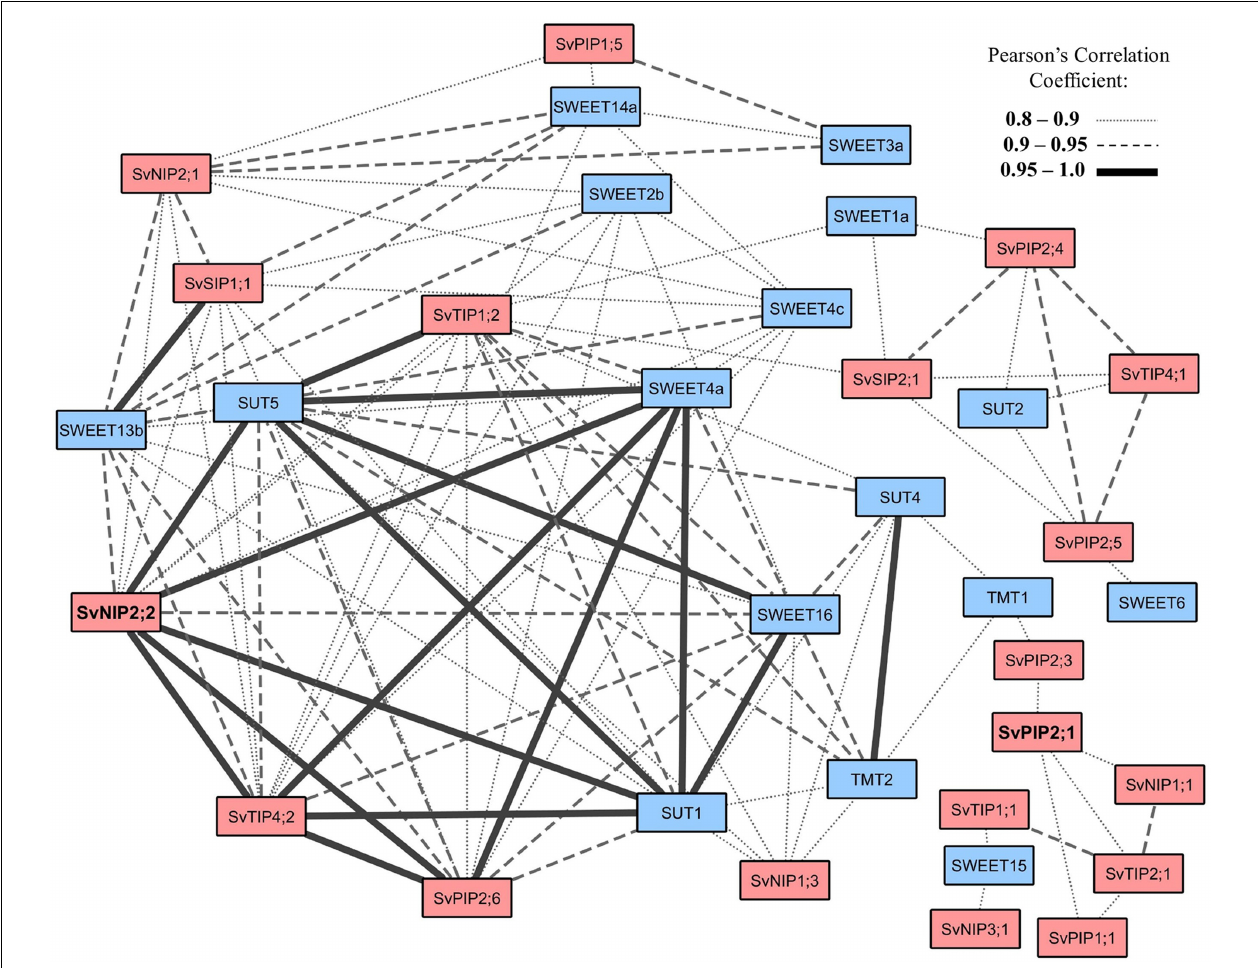
FIGURE 4 | Co-expression network of putative S. viridis aquaporin and sugar transporter genes identified in an elongating internode. The co-expressed gene network was generated from the stem specific aquaporins ( Figure 2 ) and sugar transporters identified in the S. viridis elongating internode transcriptome reported by Martin et al. (2016). Raw FPKM values were Log 2 transformed and Pearson’s correlation coefficients (0.8–1.0) were calculated in the MetScape app in Cytoscape v3.4.0. Sugar transporters in the S. viridis elongating internode were identified by homology to rice sugar transporter genes (Supplementary Figures S2–S4). Sugar transport related genes are color filled with blue and aquaporin genes with orange. SvNIP2;2 and SvPIP2;1 are in bold